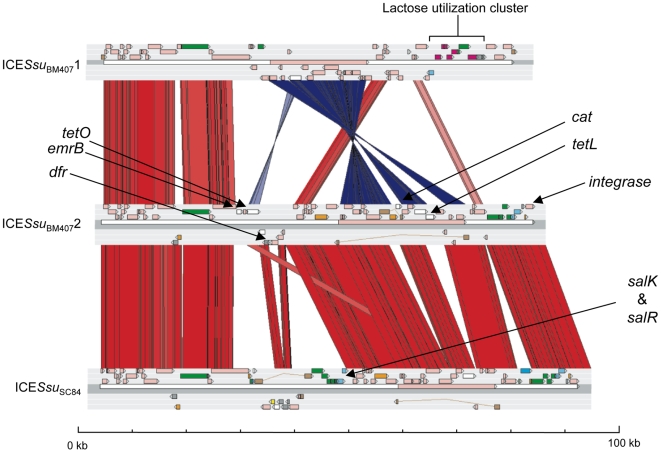
Comparisons of the ICE regions from S. suis strains BM407 and SC84.The results of a TBLASTX comparison of the ICESsu
BM4071 and ICESsu
BM4072 regions from strain BM407, and ICESsu
SC84 from strain SC84 is displayed using the Artemis Comparison Tool (ACT) [26].